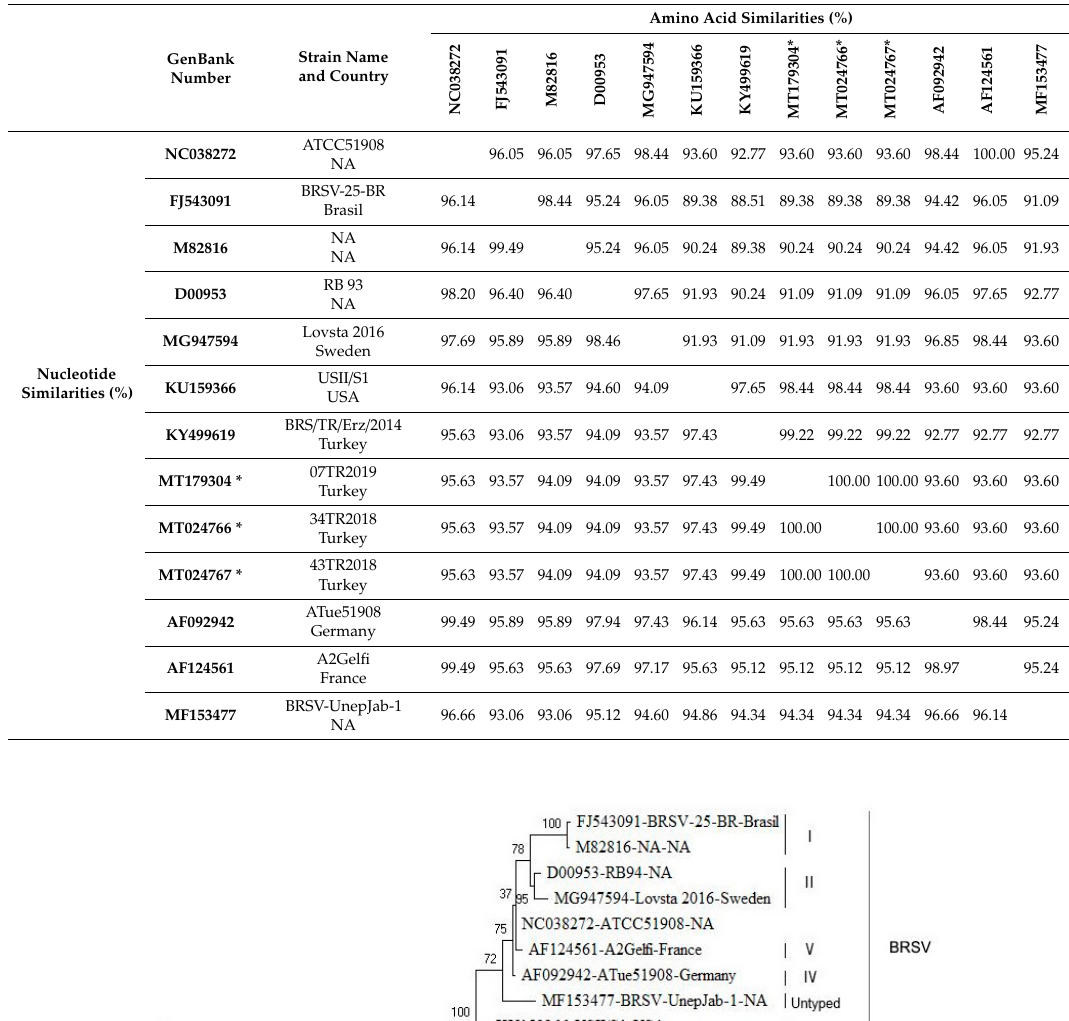
Table 2. Percentage of nucleotide and amino acid similarity between the isolates identified in this study (marked with *) and other bovine respiratory syncytial virus (BRSV) strains obtained from Genbank. NA: Not available.